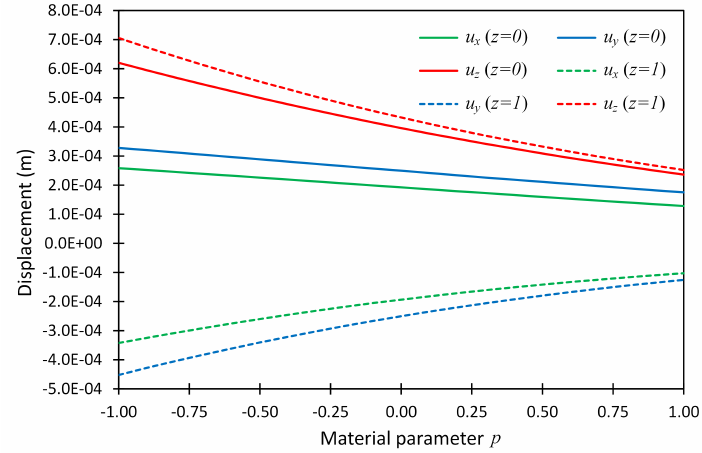
Figure 5. The displacement components at two locations ( x , y , z )=(0.75,0.75,0) and (0.75,0.75,1) versus material parameter p for Example 1 considering boundary conditions